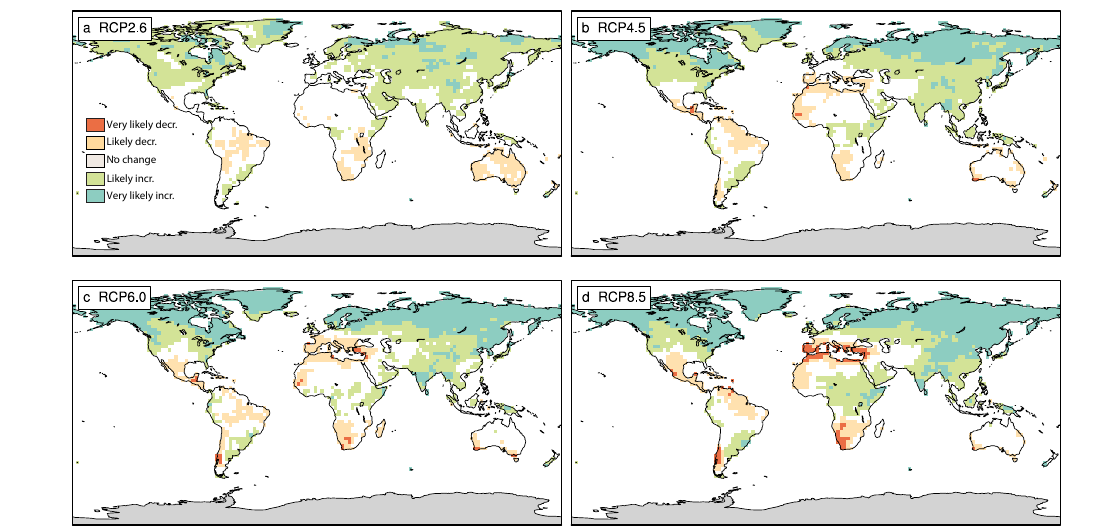
Figure 5. Conceptual summary of the probability that the slope of P is negatively/positively different from zero considering all climate models and (a) the RCP2.6, (b) the RCP4.5, (c) RCP6.0 and (d) RCP8.5 emission scenarios only. See Fig. 3 for comparison.